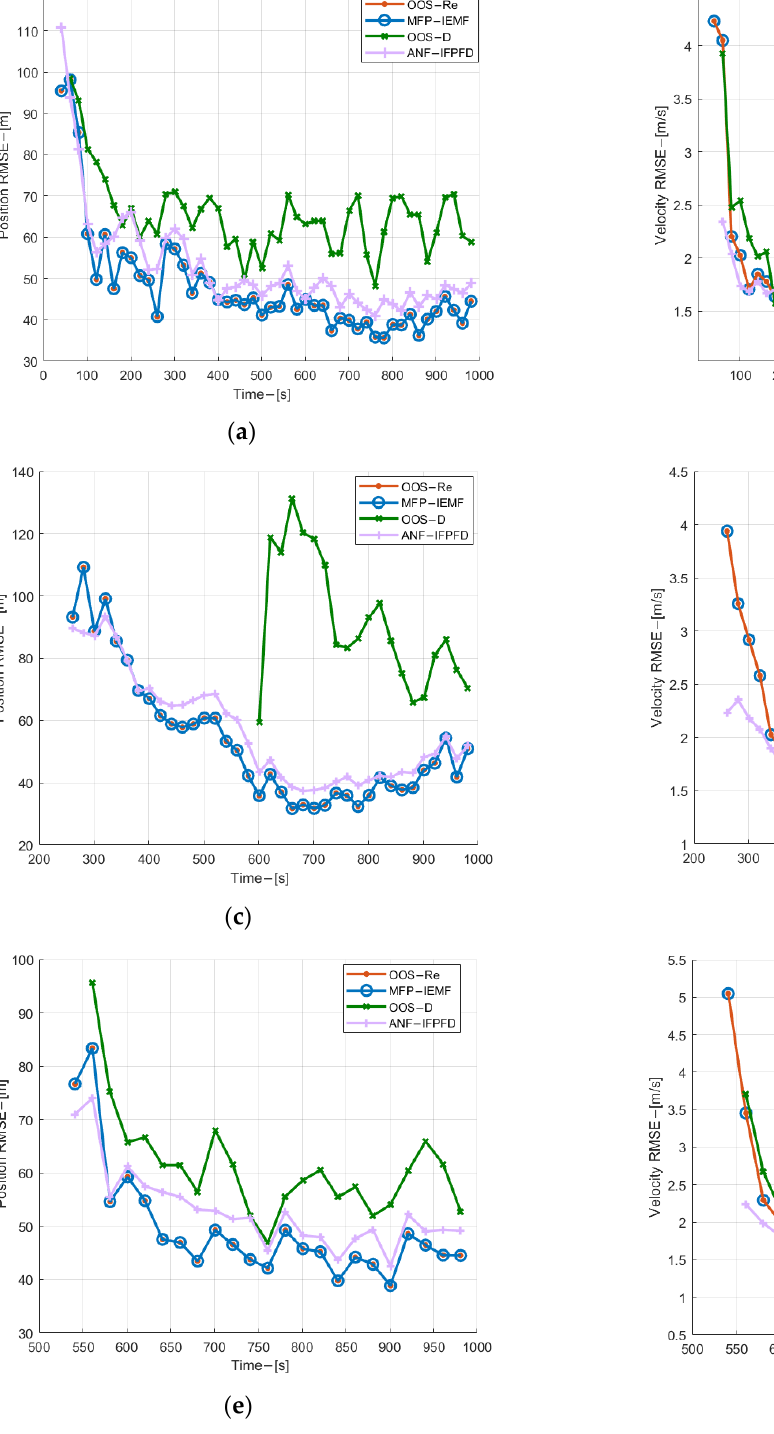
Figure 7. ANCTTs in experiment 1.